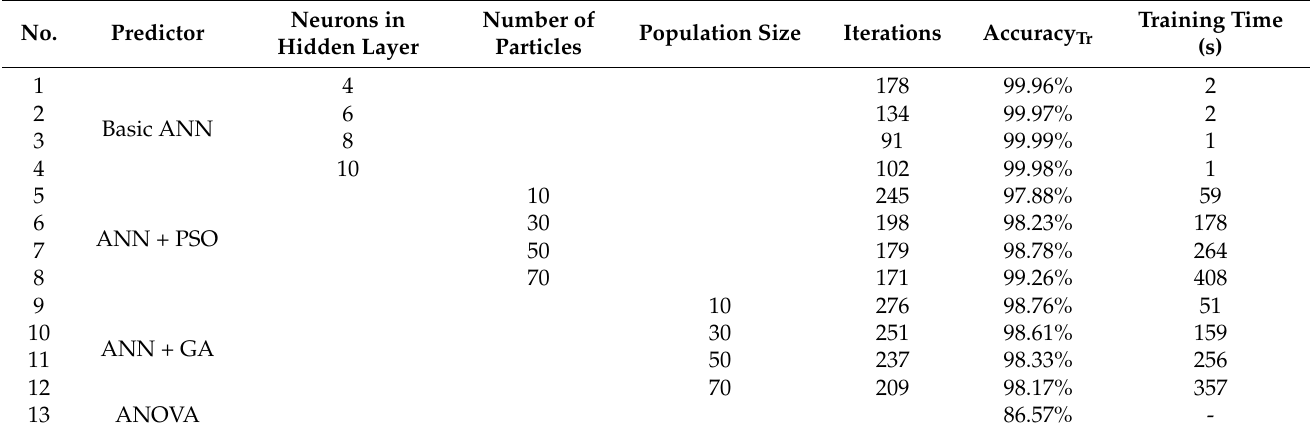
Table 7. Comparison of response prediction methods.